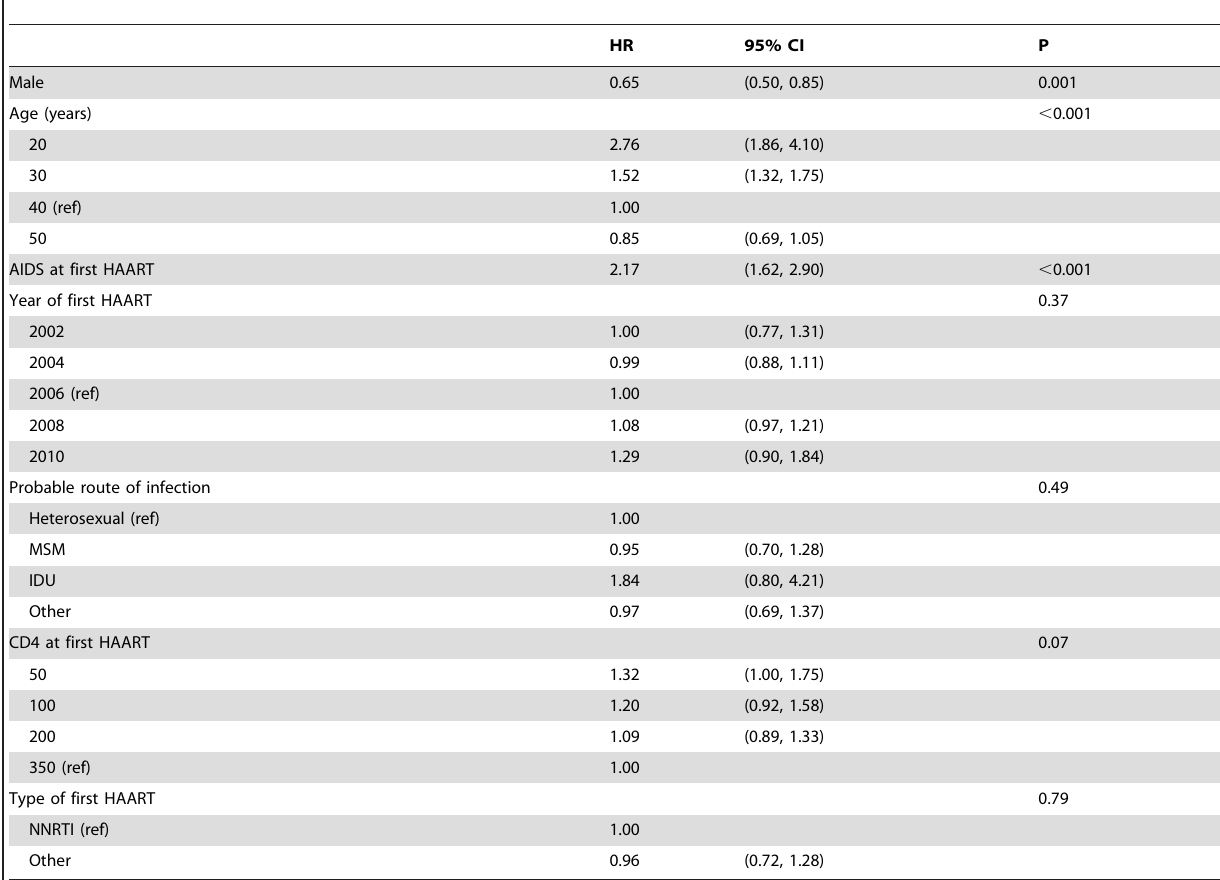
Table 4. Hazard ratios for second line failure or third line regimen